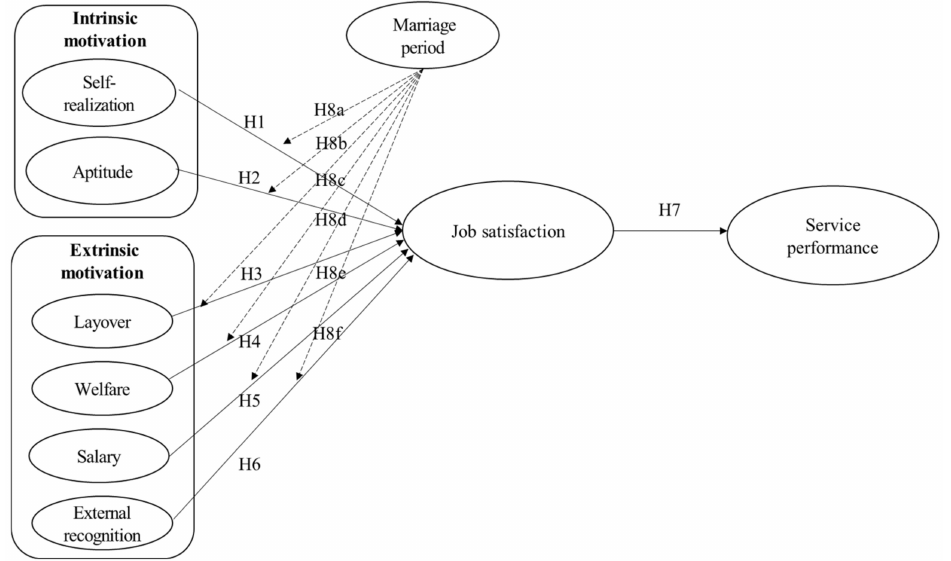
Figure 1. Research